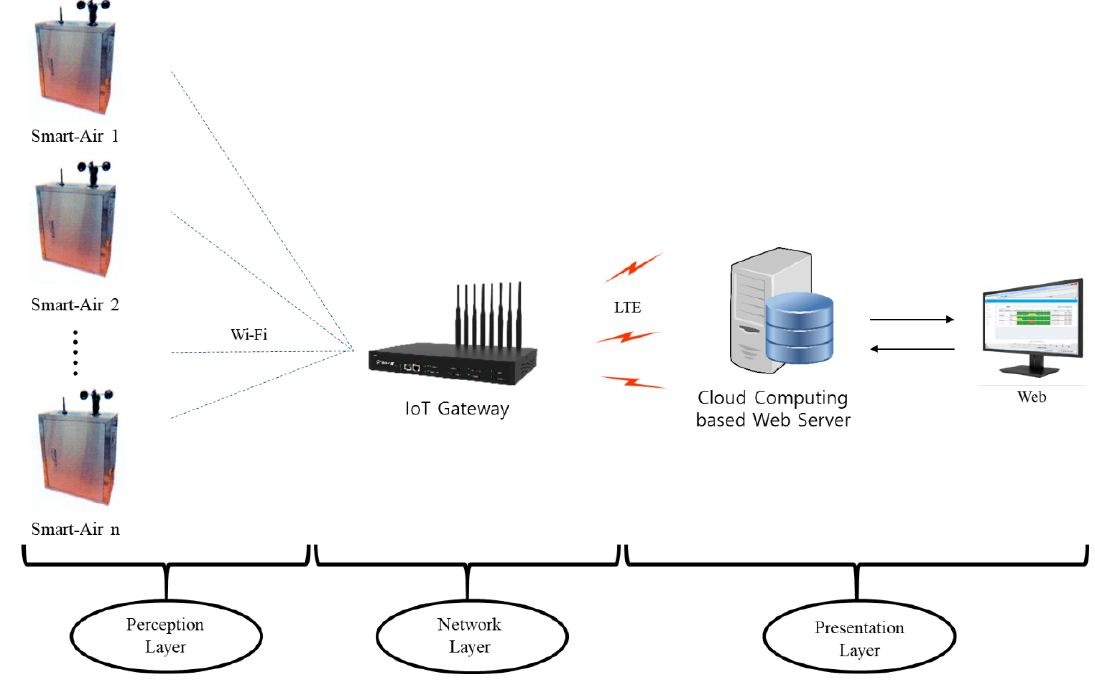
Figure 3. A system diagram of the IoT-based air quality monitoring system.